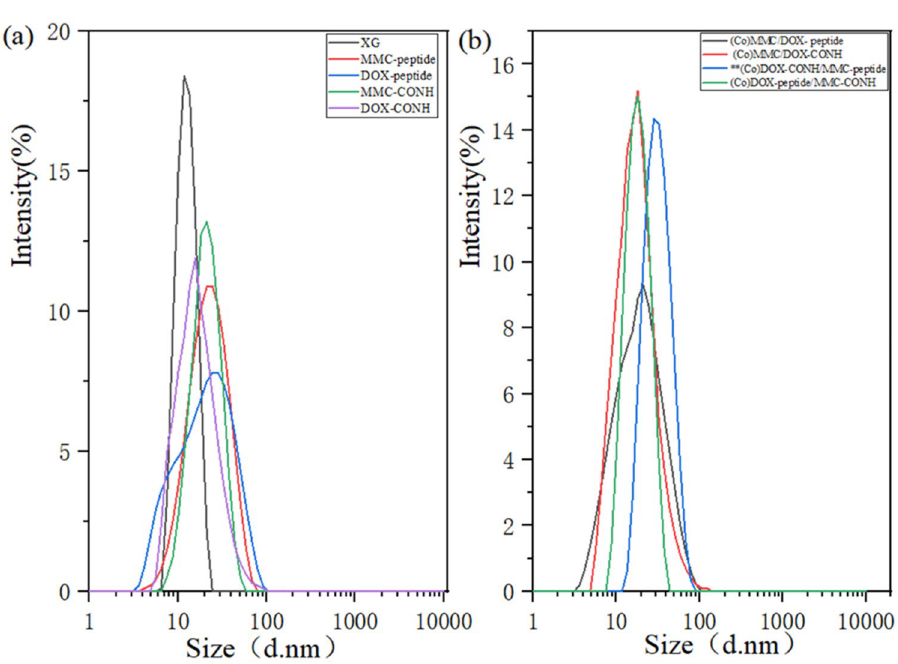
Figure 4. ( a ) Polymer size of XG, MMC-peptide, DOX-peptide, MMC-CONH,DOX-CONH ( b ) Polymer size of (Co)MMC/DOX-peptide, (Co)MMC/DOX-CONH, **(Co)DOX-CONH/MMC-peptide, (Co)DOX-peptide/